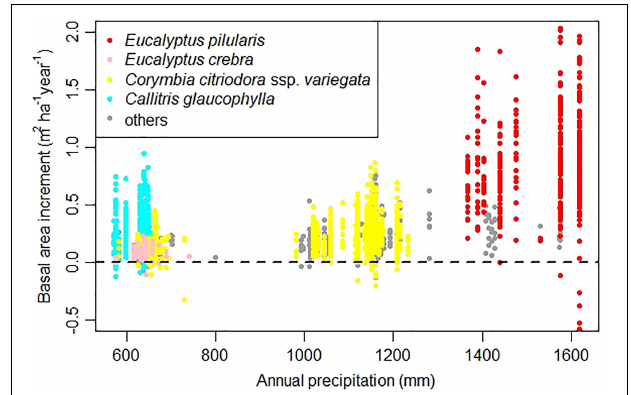
FIGURE 2 | Basal area increment vs. annual precipitation (Fick and Hijmans, 2017). We highlight four target species.